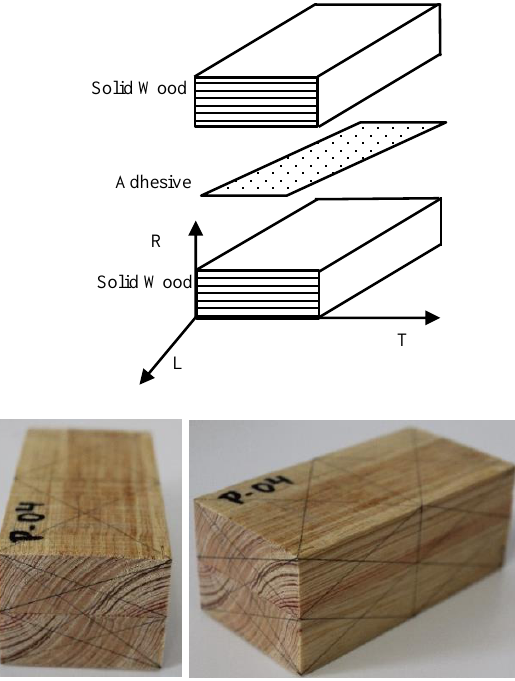
Figura 2. Laminated